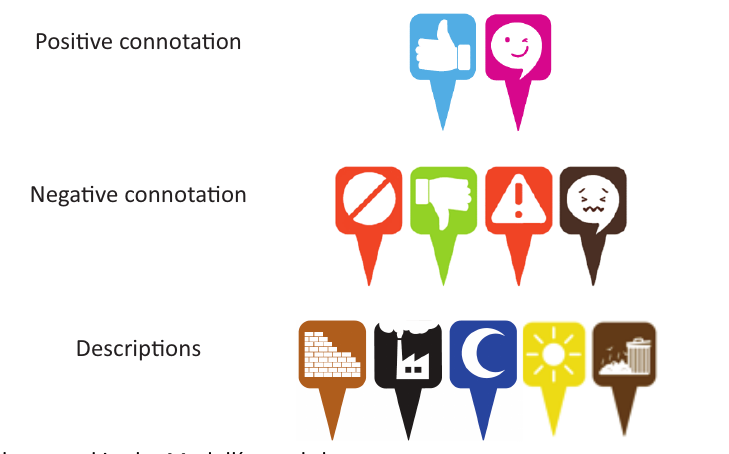
Figure 4. Iconographic stickers used in the Medellín